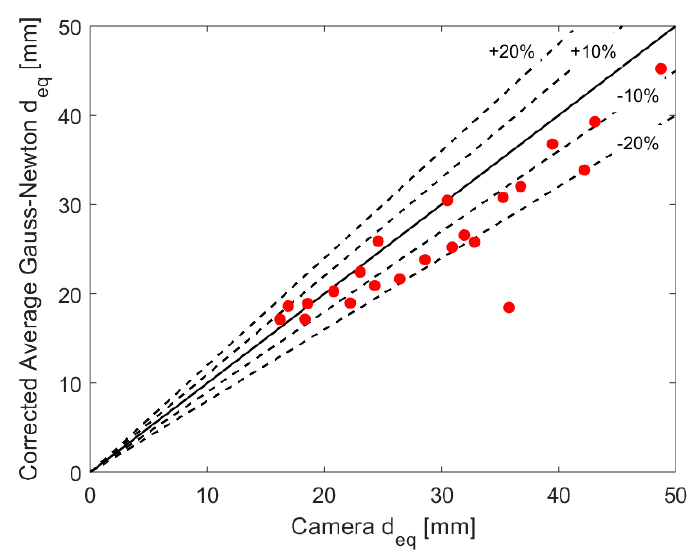
Figure 17. Calibrated gas core average equivalent diameter provided by the Averaged GN scheme plotted against the camera values.